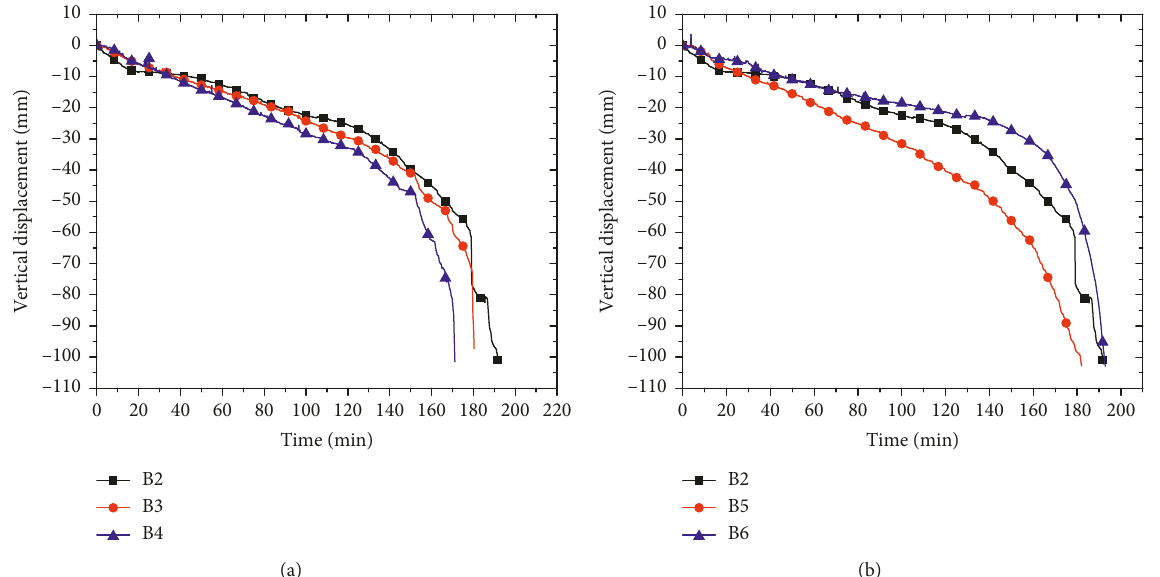
Figure 7: Measured deflection-time curve of the maximum displacement point: (a) B2, B3, and B4;(b) B2, B5, and B6.